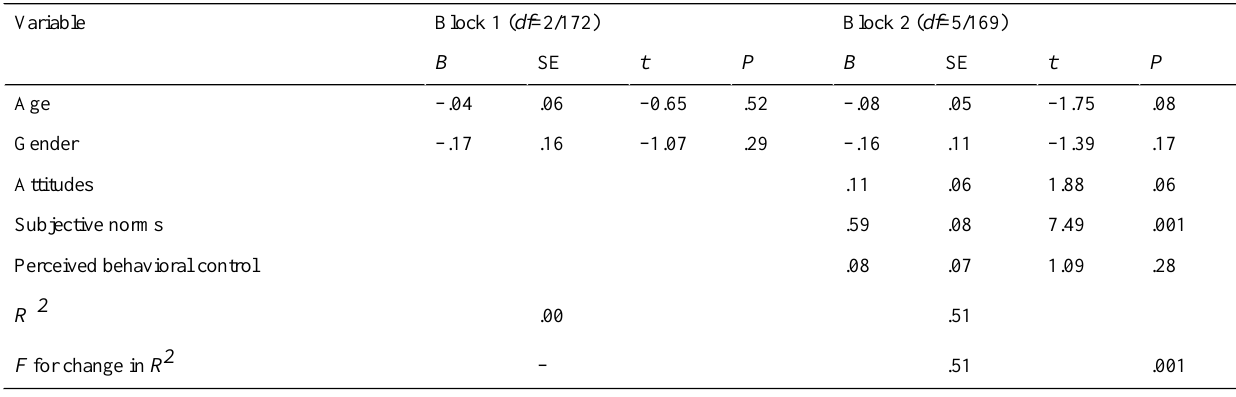
Table 6. Predictors of intentions to use social media: contributions of each variable block to changes in R2